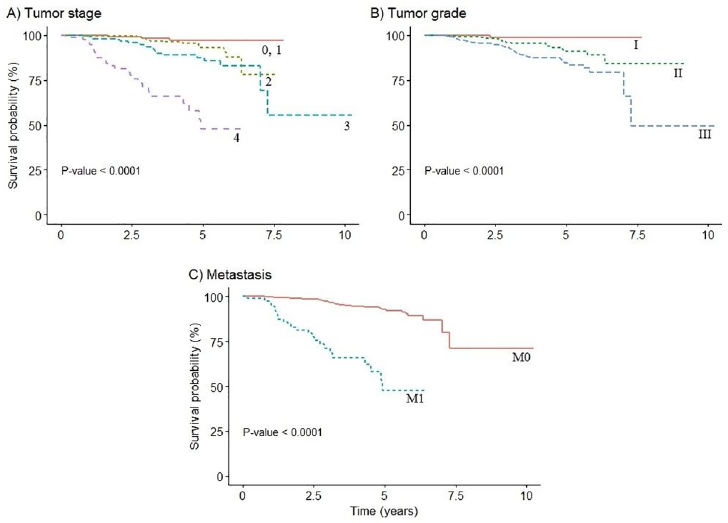
Fig 2. Overall survival curve according to selected prognostic